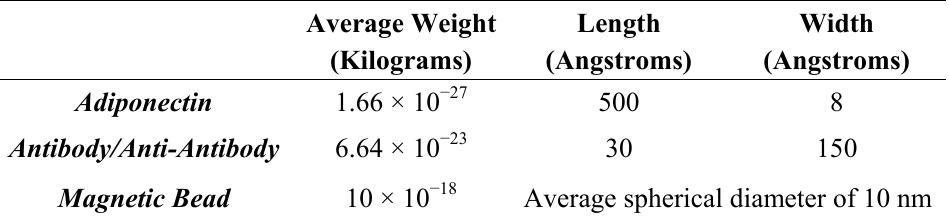
Table 1. Weight and dimensions of the each entity in the